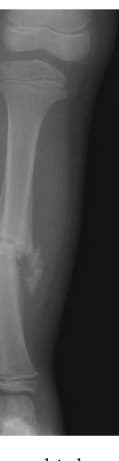
Figure 4: Hypertrophic bone callus. Figure 5: Complete radiological consolidation of the tibia fracture was achieved five months after the